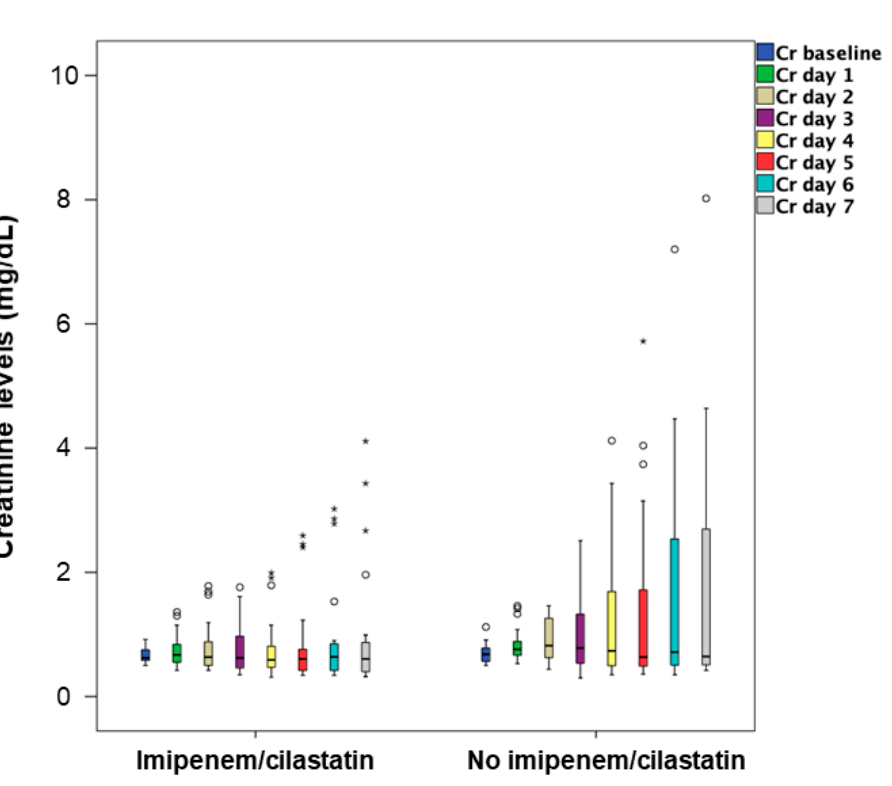
Data are presented as the means ± SD. * Statistically significant; ** at the limit of statistical signifi-